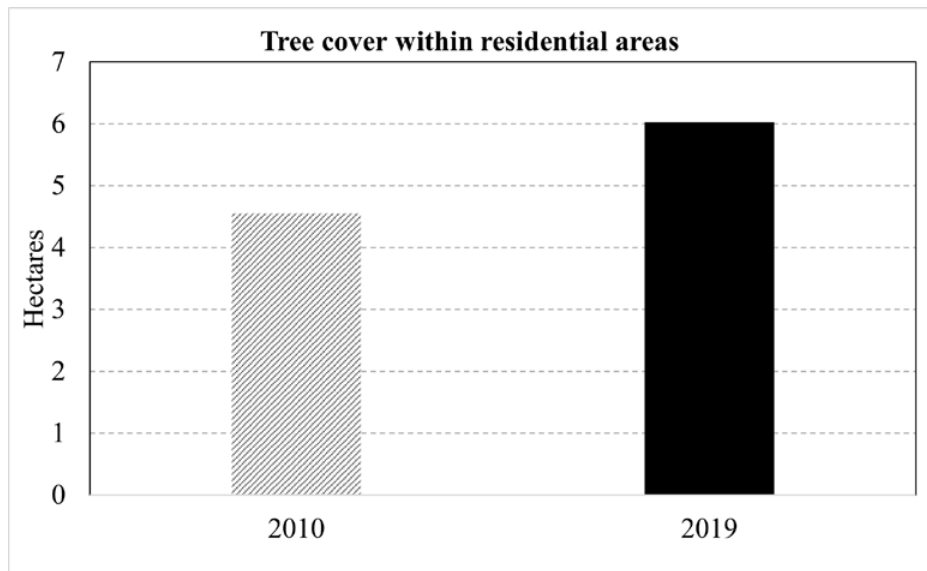
Figure 11. An increase in tree cover in residential areas in hectares from 2010 (gray diagonal bar) to 2019 (black solid bar) is attributed to maturing native trees and successful agroforestry efforts. The classes that were converted to Shrubland in 2019 are shown in Figure 12. The conversion of 2010 Evergreen Forest to Shrubland areas in 2019 is considered as land degra- dation and is seen in forest fragments within the study area, east of the BNR (Figure 13).